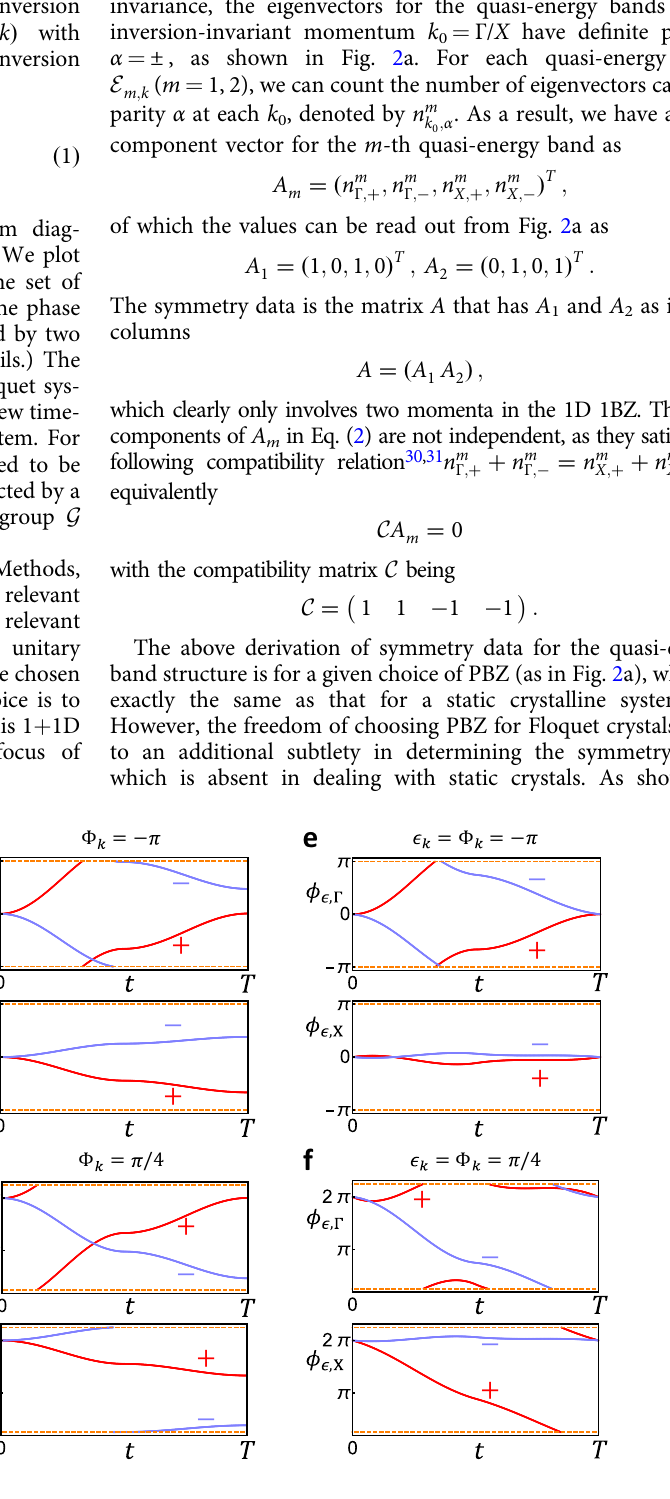
Fig. 2 Plots of phase and quasi-energy bands for the two-band 1 + 1D inversion-invariant example. We choose the PBZ lower bound as Φ k = − π in a , c , e and as Φ k = π /4 in b , d , f . In all plots, the orange dashed lines mark the boundary of the PBZ, and ± stands for the parity of the eigenvectors at Γ ( k = 0) or X ( k = π ). In a and b , we plot the quasi-energy bands (blue lines) given by U ( k , T ) in the PBZ, while all gray lines are redundant 2 π -copies outside the PBZ. All quasi-energy gaps are relevant for the topological equivalence, and thereby are relevant gaps (labeled by R.G. in the plots). In c and d , we plot the phase bands at Γ and X for the time-evolution matrix U ( k , t ). In e and f , we plot the phase bands at Γ and X for the return maps U ϵ = Φ ( k , t